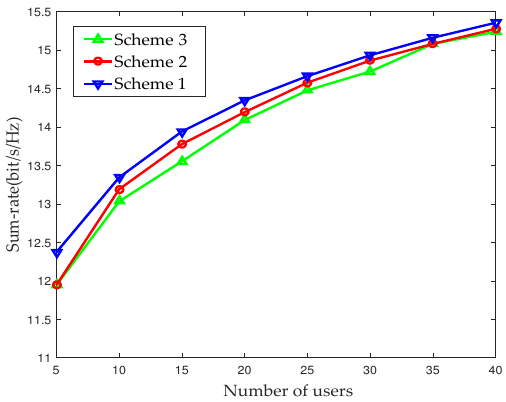
Figure 6. Sum-rate with respect to the number of UEs in single-cell.